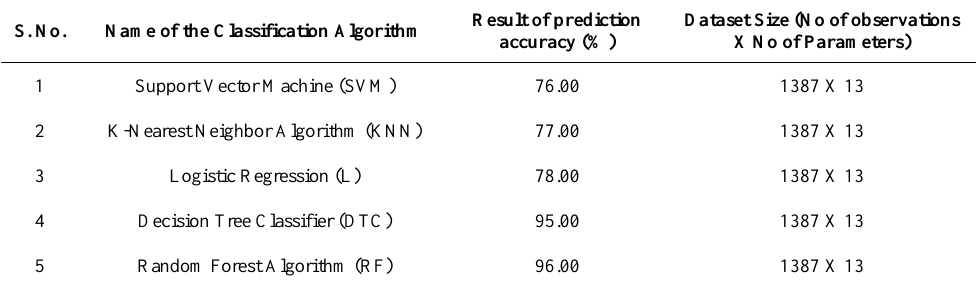
Table 1. Comparison study of results of various classification algorithms.